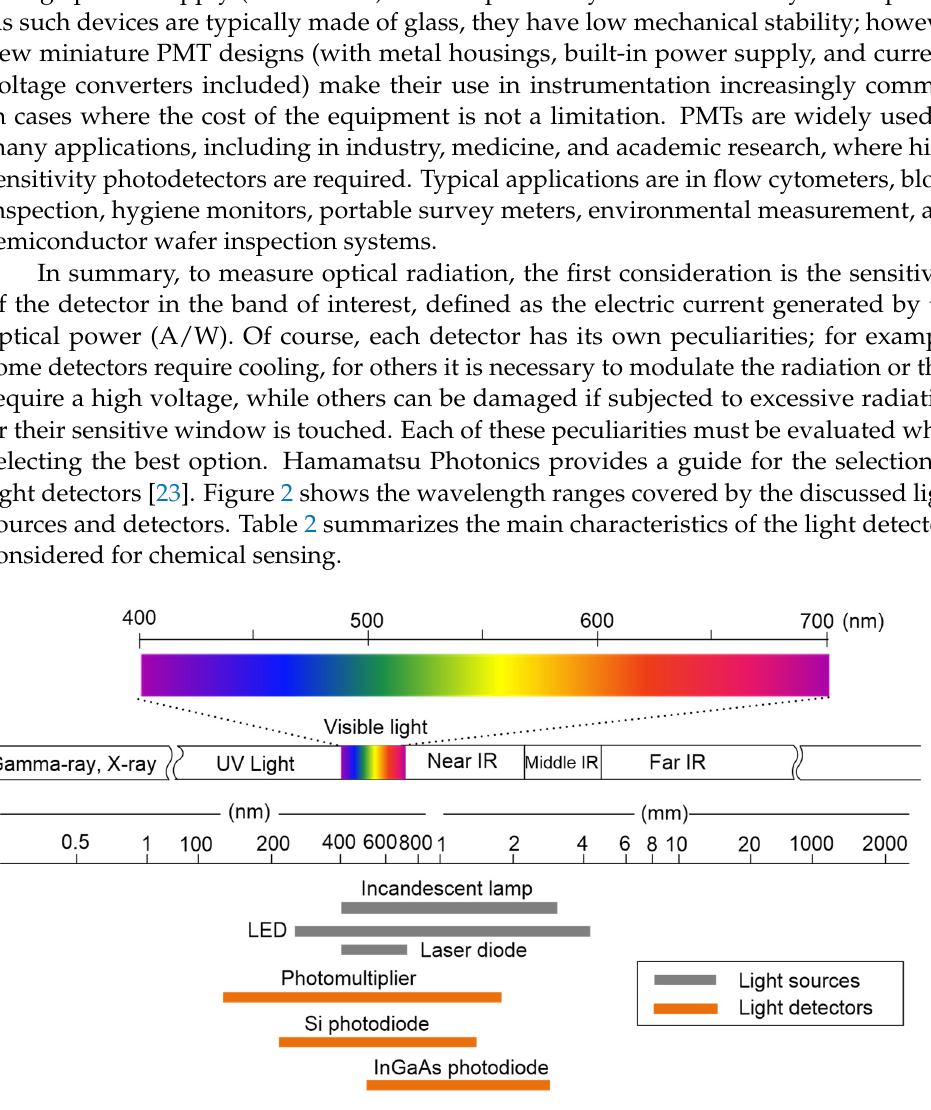
Figure 2. Wavelength ranges covered by various light sources and light detectors.